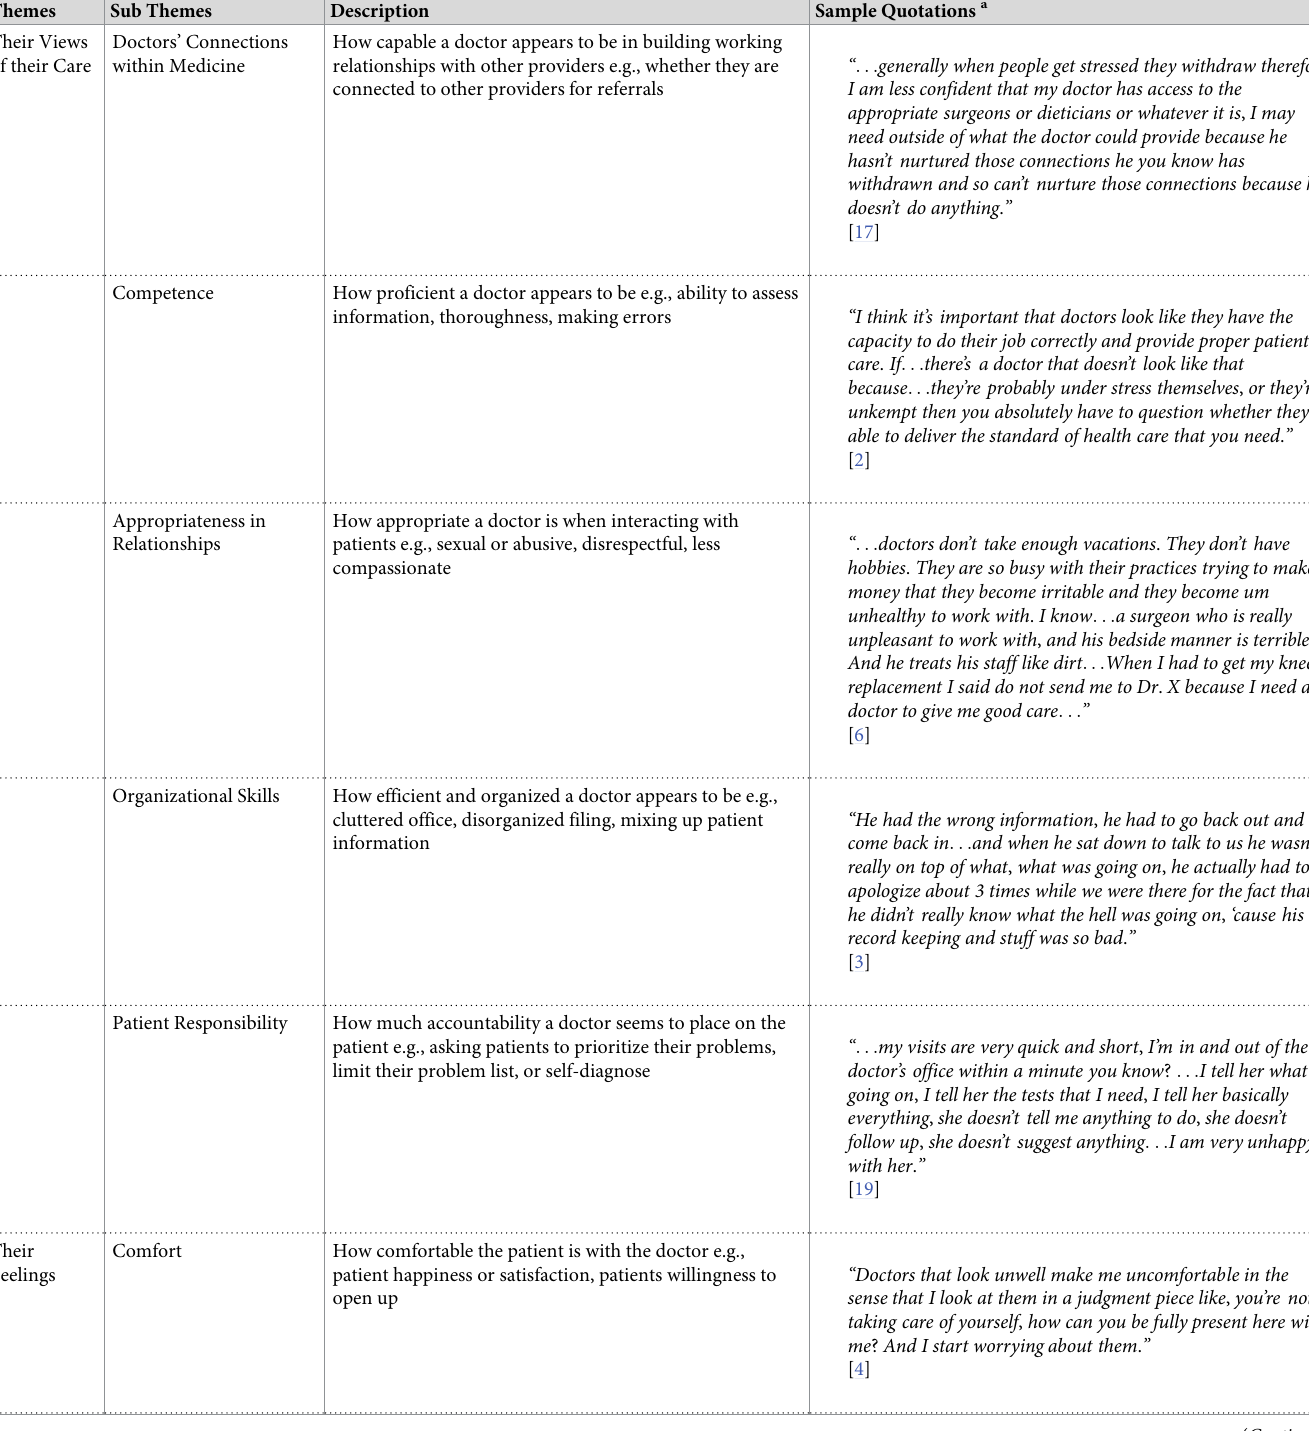
Table 2. How patients’ perceptions of physician wellness impact patients’ views of their care, their feelings, and their